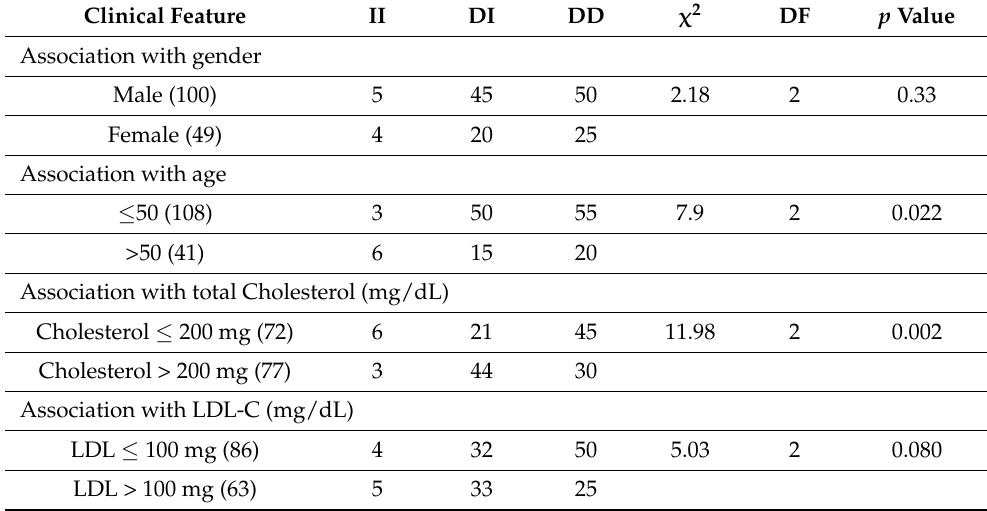
Table 5. Association of biochemical parameters and genotype distribution of ACE2 I/D genotypes and coronary artery disease